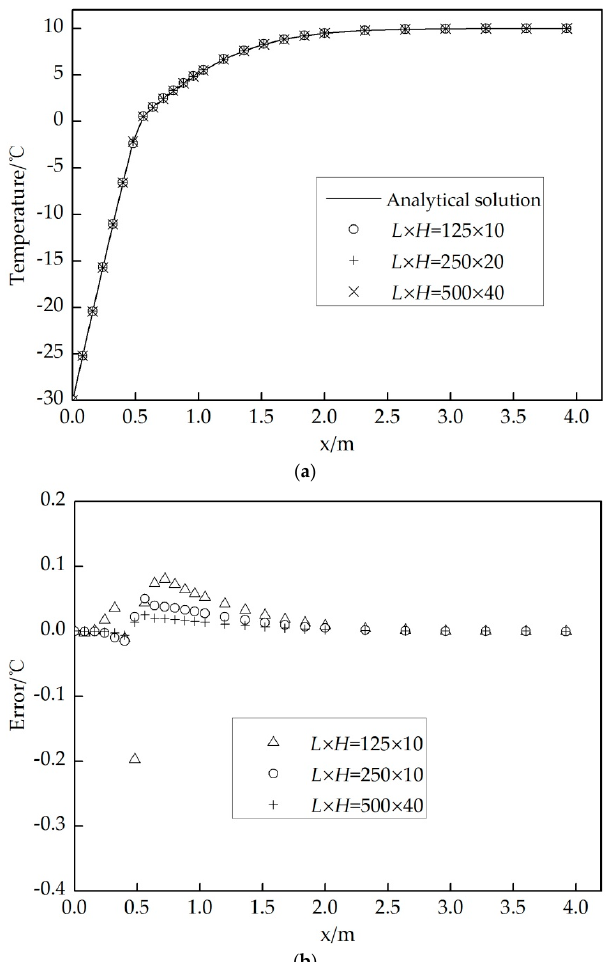
Figure 5. Comparisons between LBM and analytical solutions. ( a ) Temperature distribution; ( b ) Error distribution.